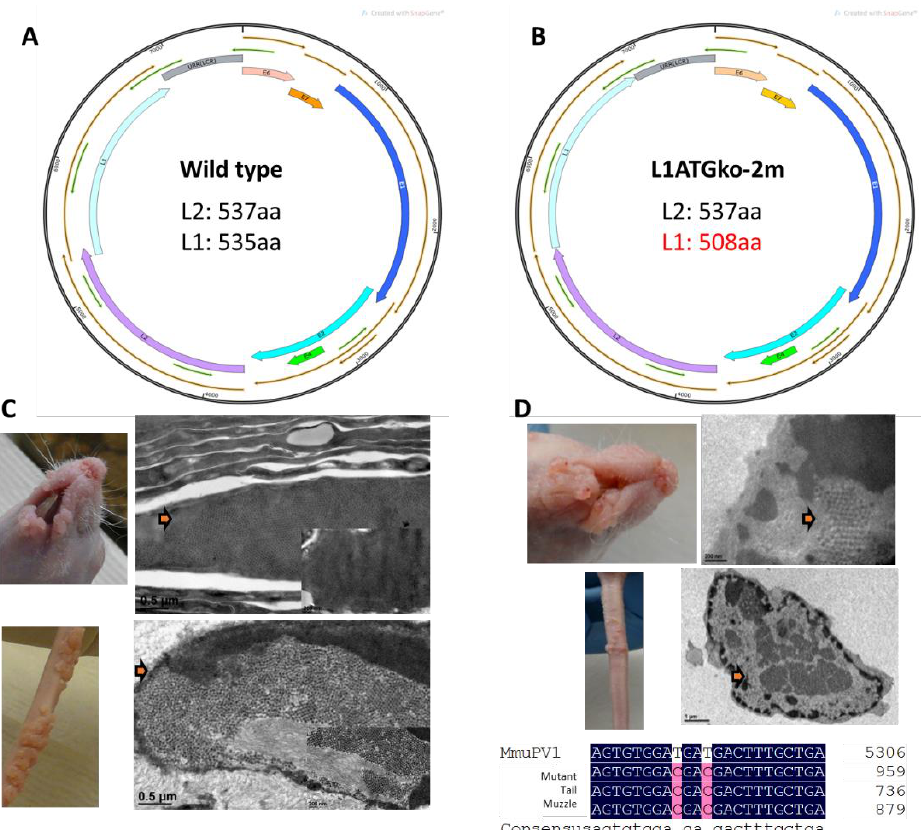
Figure 1. L1 and viral particles are detected at muzzle and tail sites in two animals with tumors induced by the L1ATGko-2m mutant. L1 with the first two methionines mutated to ACG (L1ATGko-2m) results in a shorter L1 (508aa) if the protein is expressed from the third methionine of the sequence ( B ), minus 27aa of the wild-type L1 ( A ). Viral particles ( C and D , arrows) were detected in wild-type ( C ) and L1ATGko-2m mutant ( D ) induced muzzle lesions (upper panel) and in tail lesions (lower panel) by transmission electron microscopy (TEM). Mutation of the first two L1 methionines was confirmed in the viral DNA extracted from these lesions by DNA sequencing following rolling circling amplification (bottom, D ). L1 was also detected in these lesions by immunohistochemistry (IHC) with an in-house monoclonal antibody (MPV. B9) against the mouse papillomavirus major capsid protein L1 (data not shown).